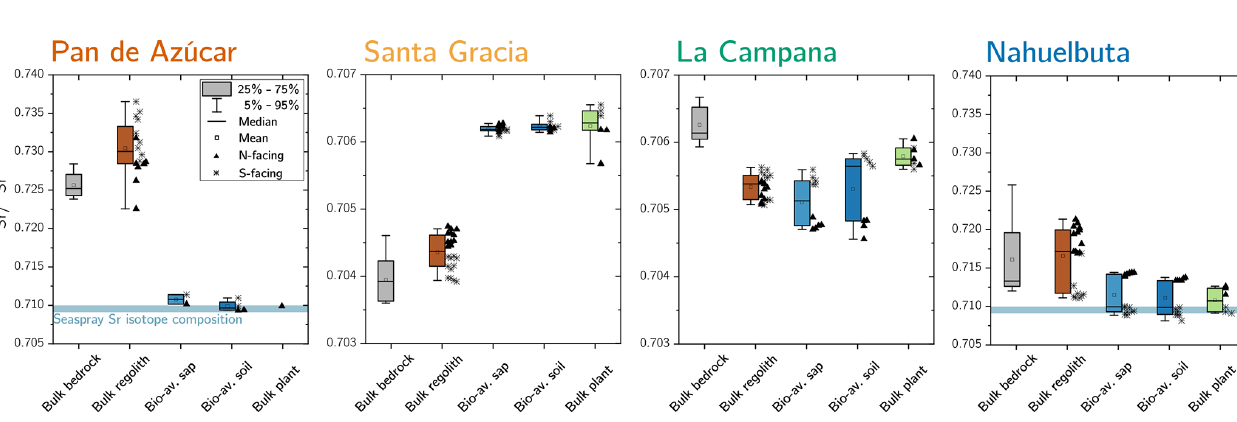
up to several times. U X regolith